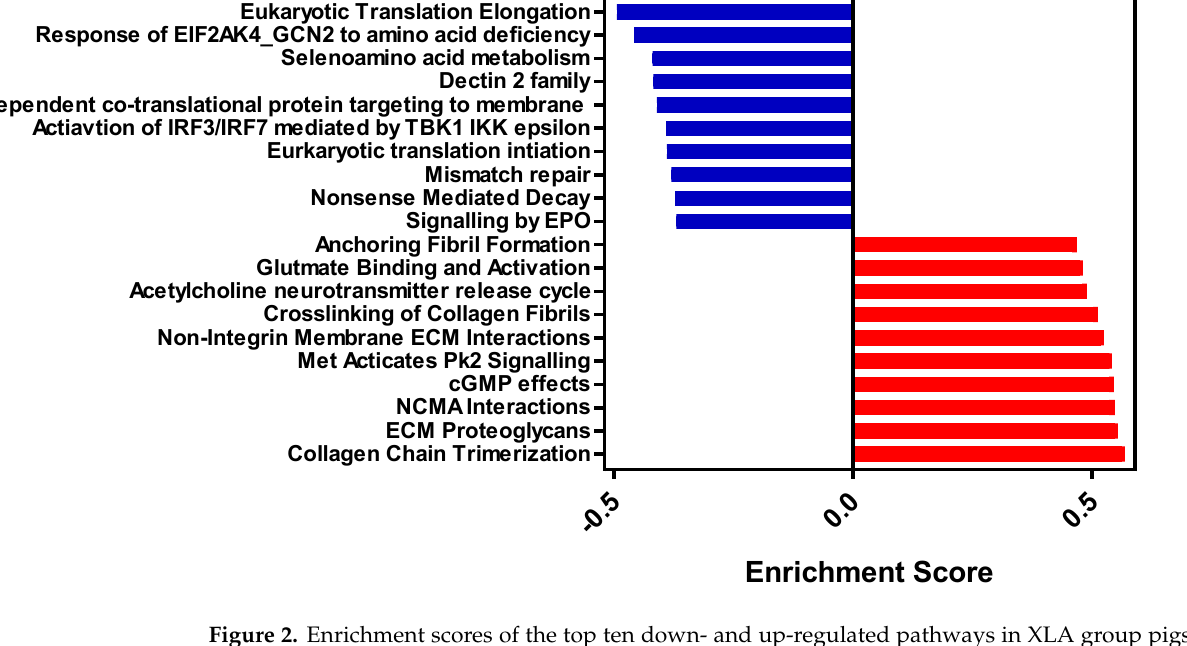
Figure 2. Enrichment scores of the top ten down- and up-regulated pathways in XLA group pigs relative to PC group pigs, from REACTOME database as identified by GSEA (for all pathways Q-value < 0.05). PC = Positive control with medicinal zinc oxide, XLA = Extra low protein diet with non-marked amino acids.